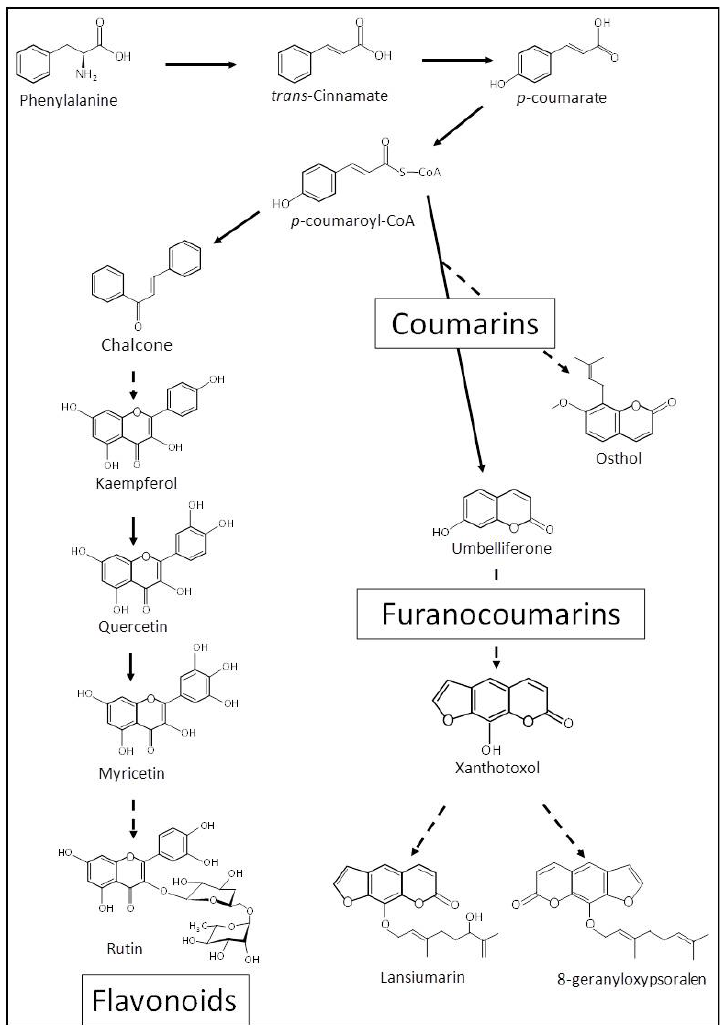
Figure 3. Schematic diagram of putative p -coumaroyl-CoA competition between flavonoid and furanocoumarin pathways. Continuous arrows represent a one-step reaction; dotted arrows represent several enzymatic reactions.